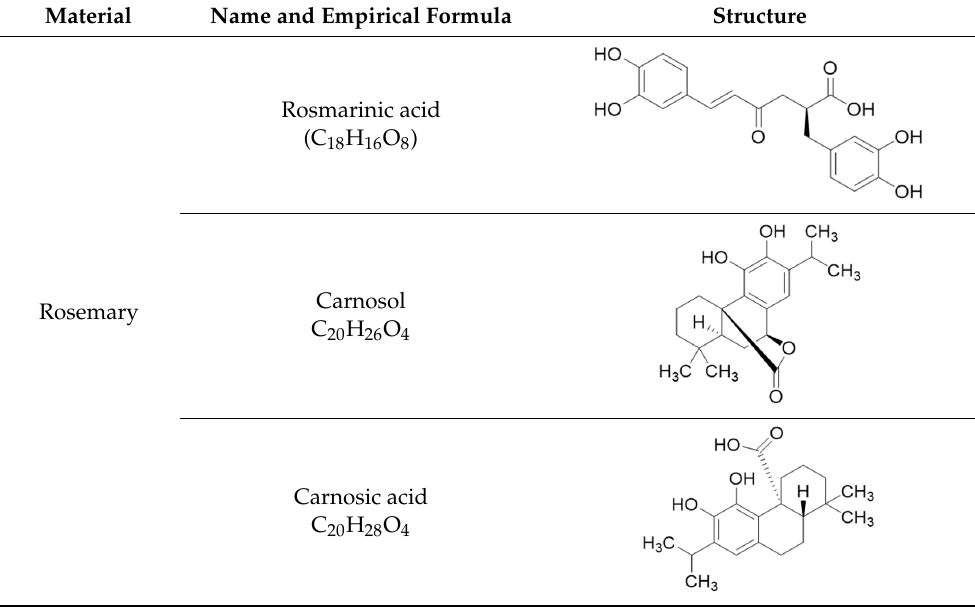
Table 3. Main compounds and structures present in the extracts obtained by environmentally friendly techniques of some spices [59–62].